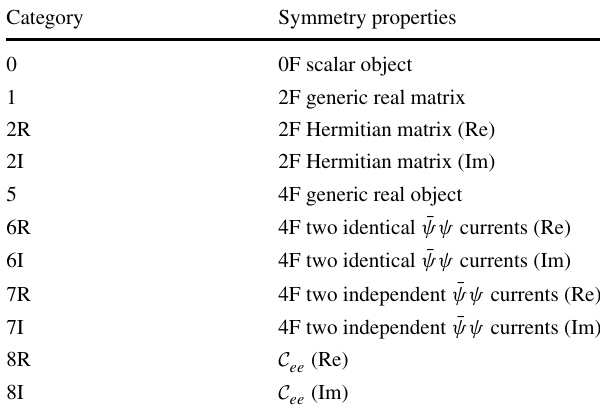
Table3 SymmetrycategoriesforoperatorsintheSMEFT.nFindicates the number of flavour indices for each